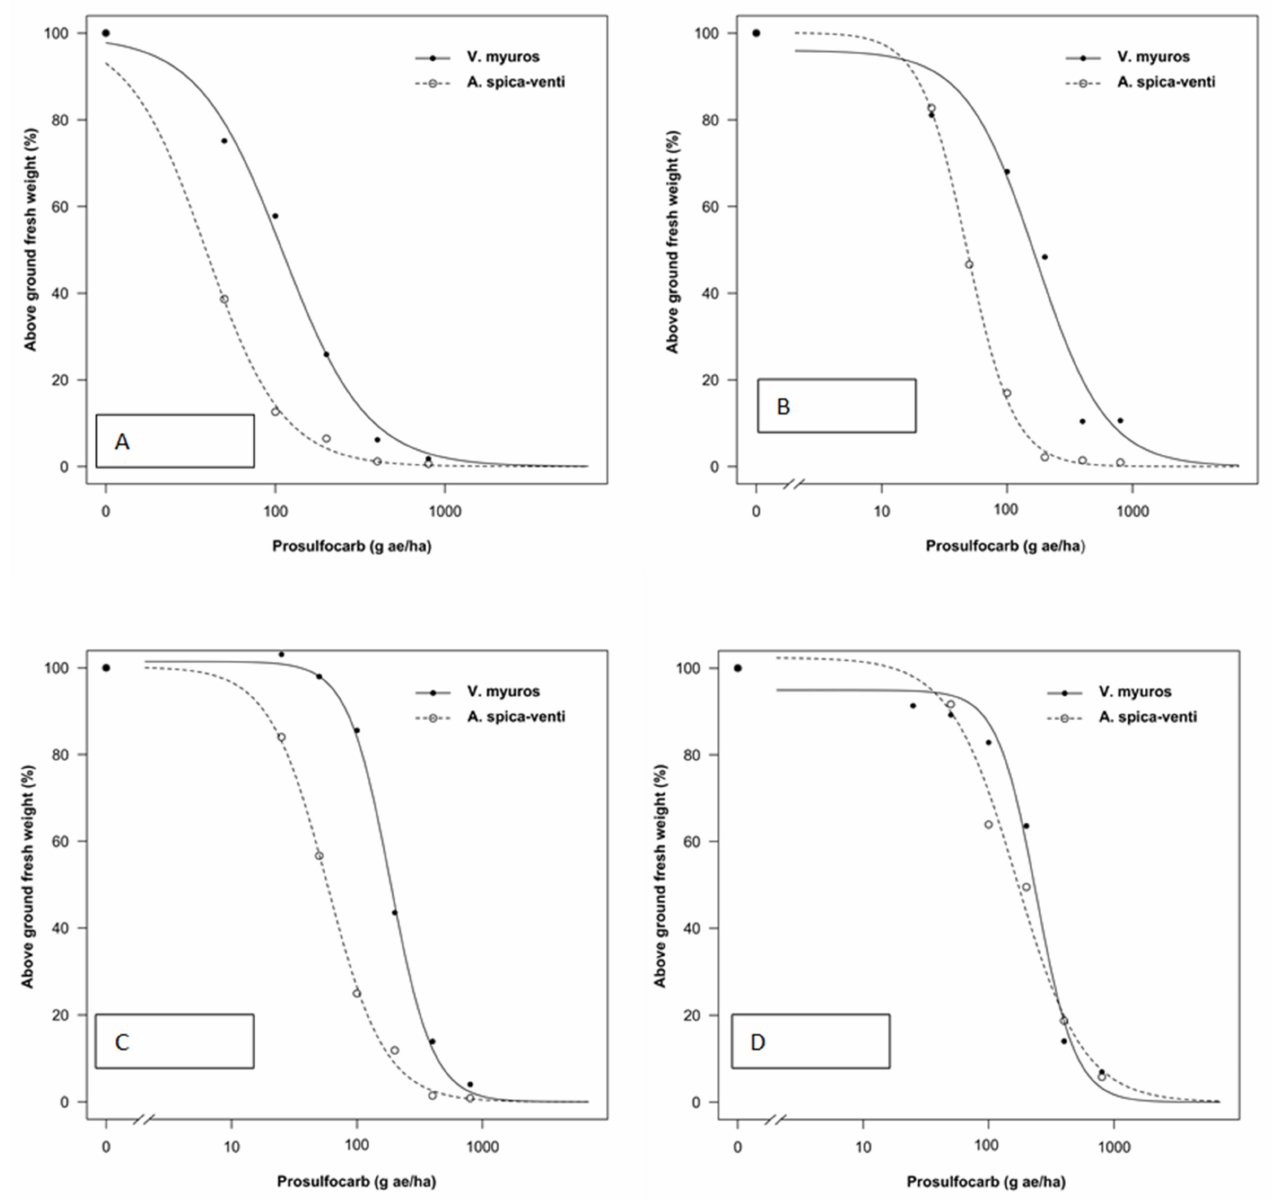
Figure 2. Prosulfocarb dose–response on aboveground fresh weight represented as percentage of untreated control of Vulpia myuros and Apera spica-venti in Experiment 2 at: BBCH 00 ( A ); BBCH 10 ( B ); BBCH 11 ( C ); and BBCH 12 ( D